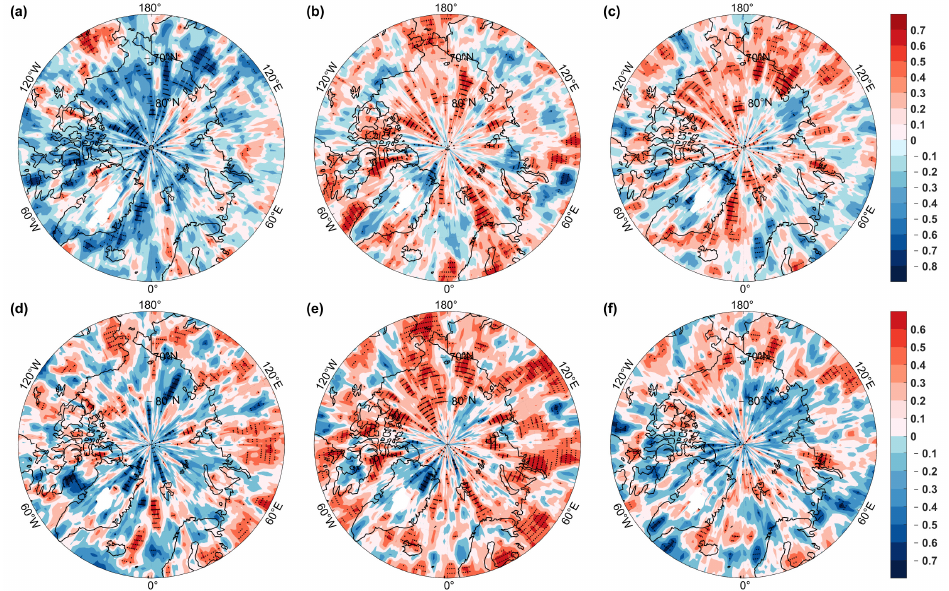
Figure 4. Correlation between cyclone frequency and cloud fraction in the autumns of 2001–2017 for ( a ) the low cloud (surface–700 hPa), ( b ) the mid-low cloud (700–500 hPa), and ( c ) the mid-high cloud (500–300 hPa) from the CERES data, and ( d ) the low cloud (1.0 > sigma > 0.8), ( e ) the mid-cloud (0.8 ≥ sigma > 0.45), and ( f ) the high cloud (0.45 ≥ sigma) from the ERA5 data, in which the sigma is a parameter that indicates how many times the pressure at the altitude is the sea surface pressure. The black dots denote the 95% confidence level.